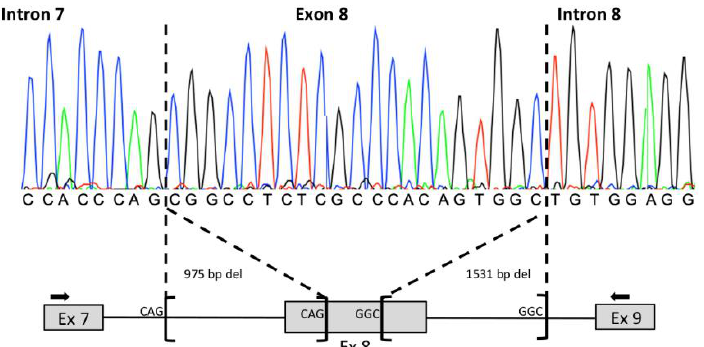
Figure 5. Sanger validation of the GSDME exon 8 deletion in the proband II:3. At the top: sequence chromatogram focused on the breakpoints of the deletions. At the bottom: schematic representation of the complex rearrangement. The position of the primers used for the amplification is shown by arrows. The 3 bp flanking microhomologies are indicated.